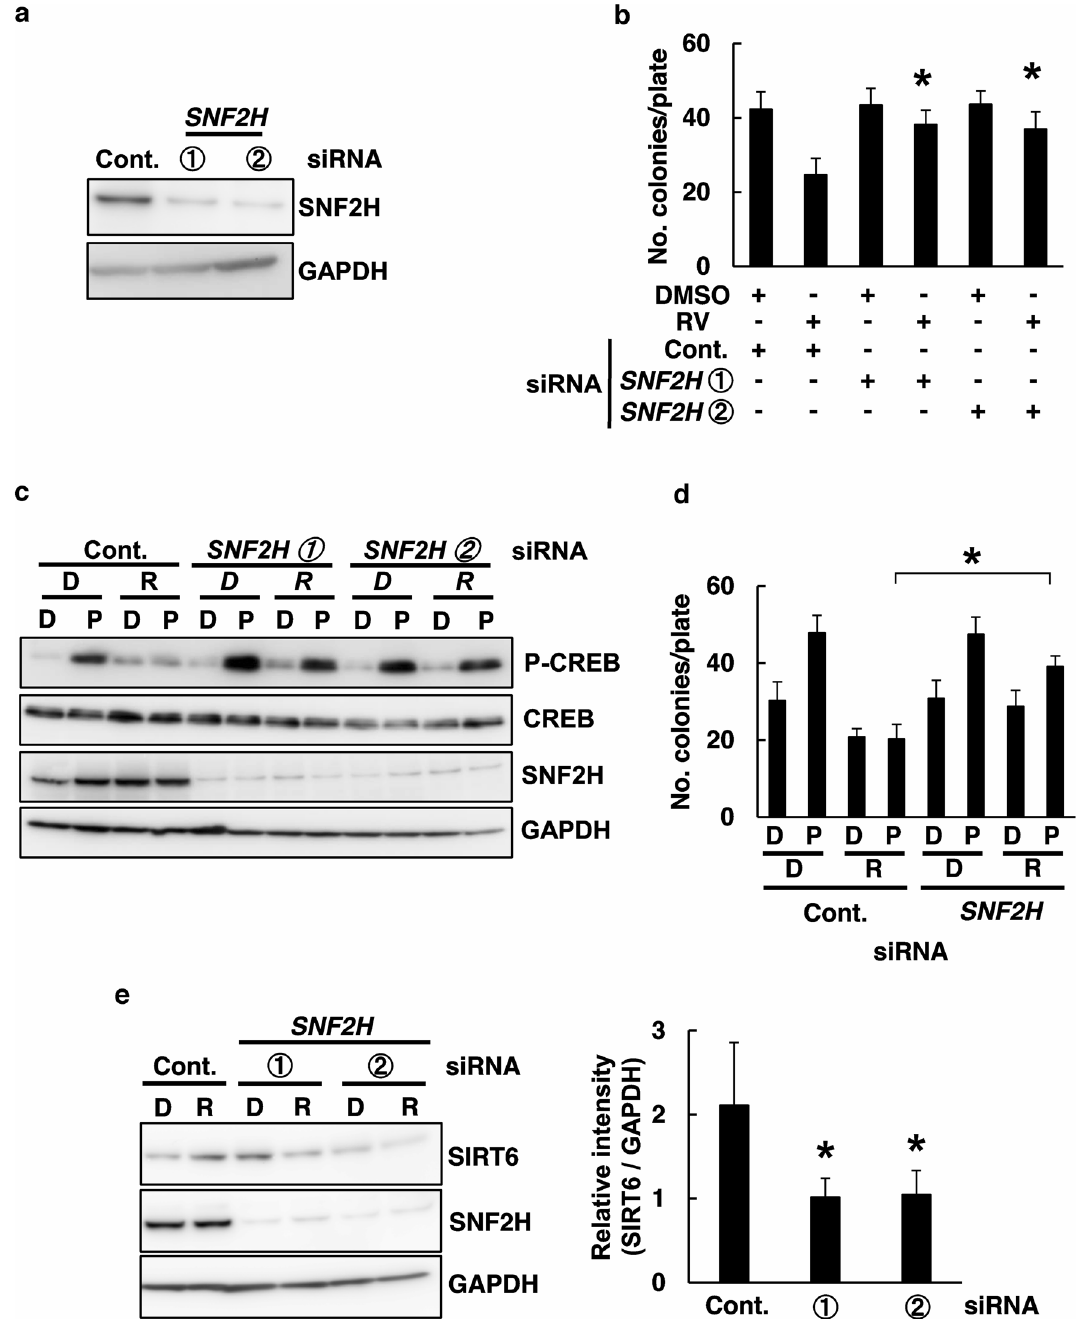
Figure 4. Inhibition of L1-RTP by RV depends on SNF2H. ( a ) Effects of SNF2H siRNA on the expression of the endogenous SNF2H protein. HeLa cells were transfected with pL1-Neo R and siRNA. Cont.; Control siRNA (10 nM); ① and ② ; SNF2H siRNA-1 or siRNA-2 (10 nM). ( b ) SNF2H was required to inhibit L1-RTP by RV. A colony formation assay was performed for HeLa cells after introducing either control siRNA or SNF2H siRNAs-1 or -2. The cells were treated with 0.02% DMSO or 20 μM RV for 2 days. The mean numbers of colonies ± SD are shown. The effects of SNF2H siRNAs were significant (* p < 0.01). ( c ) Downregulation of SNF2H the phosphorylation of CREB by PhIP. HeLa cells after introducing either control siRNA at 10 nM or SNF2H siRNA-1 or 2 at 10 nM. HeLa cells were first transfected with SNF2H siRNA, and then treated with RV (20 μM; R) to the culture medium 30 min before the addition of DMSO (0.02%; D) or PhIP (18 μM; P) for 30 min. ( d ) Downregulation of SNF2H blocked the inhibition of L1-RTP by RV. A colony formation assay was performed for HeLa cells after introducing either control siRNA or SNF2H siRNA-1. 0.02% DMSO: D, 18 μM PhIP: P, 20 μM RV: R. ( e ) RV-mediated SIRT6 expression depends on SNF2H. SNH2H is pivotal for RV-induced SIRT6 expression. WB analysis was performed after introducing either control siRNA or SNF2H siRNA-1,2. The cells were treated with DMSO (0.02%; D) or RV (20 μM; R) for 2 days. The relative intensity ± SD is